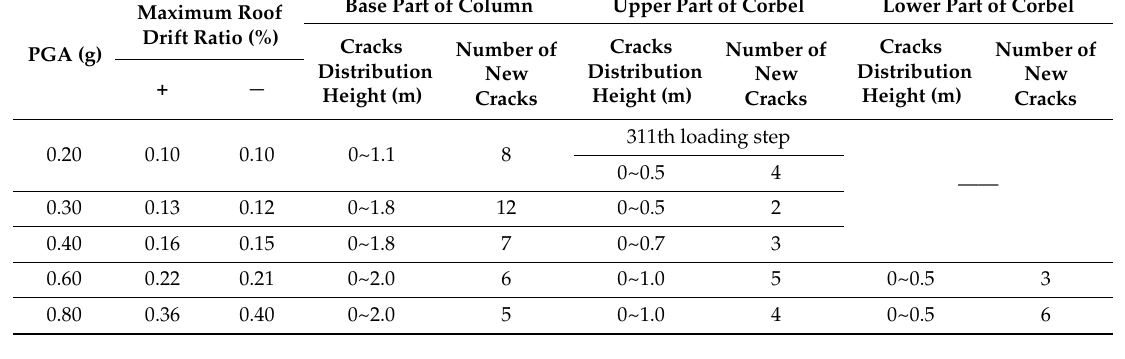
Figure 8. Measured strains versus base shear force of the steel truss and diagonal braces under the final loading case of PDTs with PGA of 0.80 g. Figure 9. Observed cracking patterns of tubular columns at the end of PDTs: ( a ) Bottom of column; ( b ) Lower part of corbel; ( c ) Upper part of corbel.